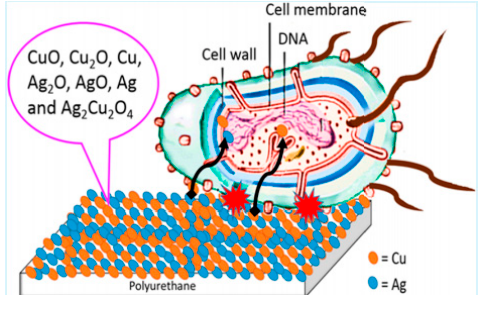
Figure 7. Antibacterial illustration of Cu–Ag-sputtered polyurethane (PU) catheters [54].